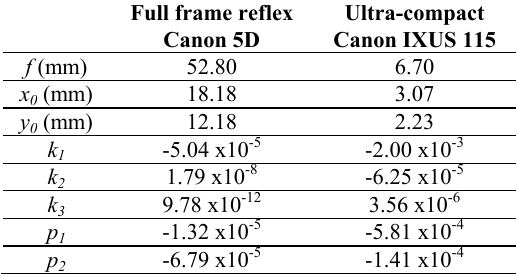
Table 6. Internal orientation parameters of the cameras boarded in the aerial platforms.